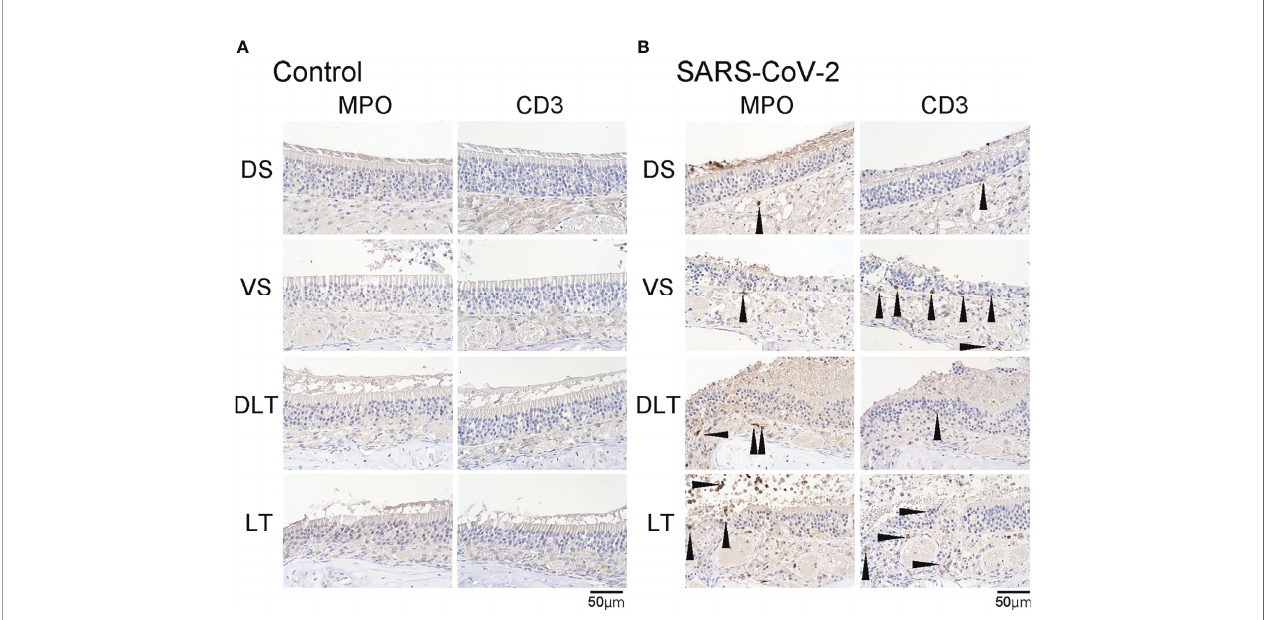
FIGURE 3 | In fl ammatory cell in fi ltration in the olfactory mucosa. (A, B) Representative images of immunohistological staining of MPO and CD3 in control hamsters (A) and severe acute respiratory syndrome coronavirus 2 (SARS-CoV-2) hamsters (B) . (B) In the SARS-CoV-2 group, some MPO + and CD3 + cells are present in the olfactory